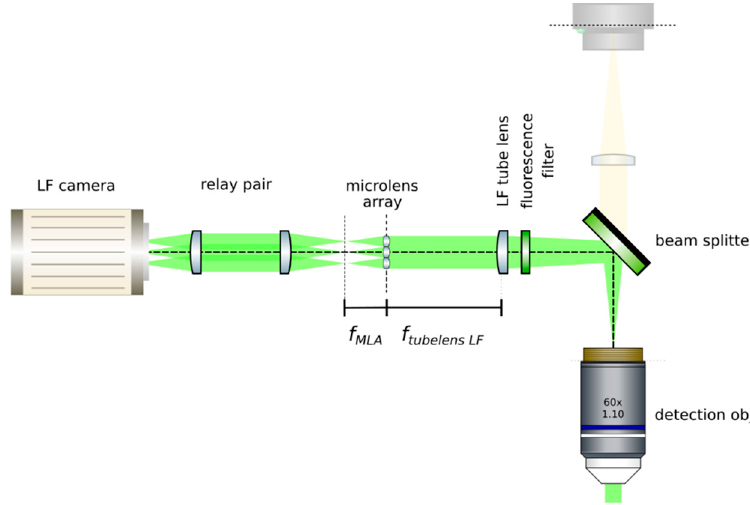
should appear in focus with the correct magnification (from the relay).